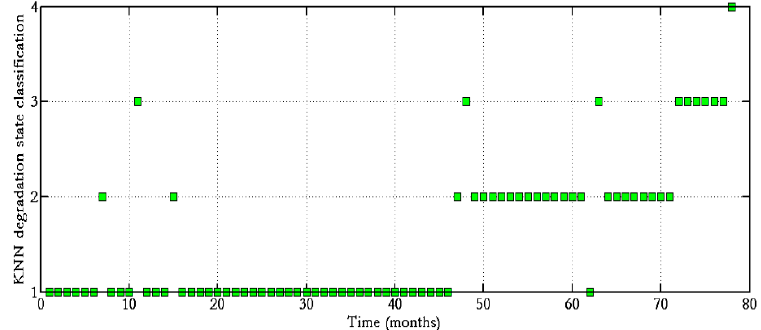
Figure 4. Classification of the degradation state during the degradation trajectory of Figure 3. The true degradation state of the component is state 1: from to 46, state 2: from 46 to 71, state 3: from 72 to 77, and state 4: at time 78.